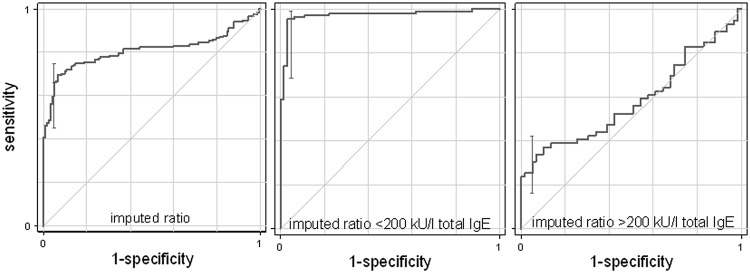
ROC curves analysis.ROC curves (with vertical line presenting the 95% confidence interval of sensitivity at 90% specificity) for imputed specific/total IgE ratio in the whole sample (left), as well as in subjects with total IgE values below (center) or above (right) total IgE values of 200 kU/l.